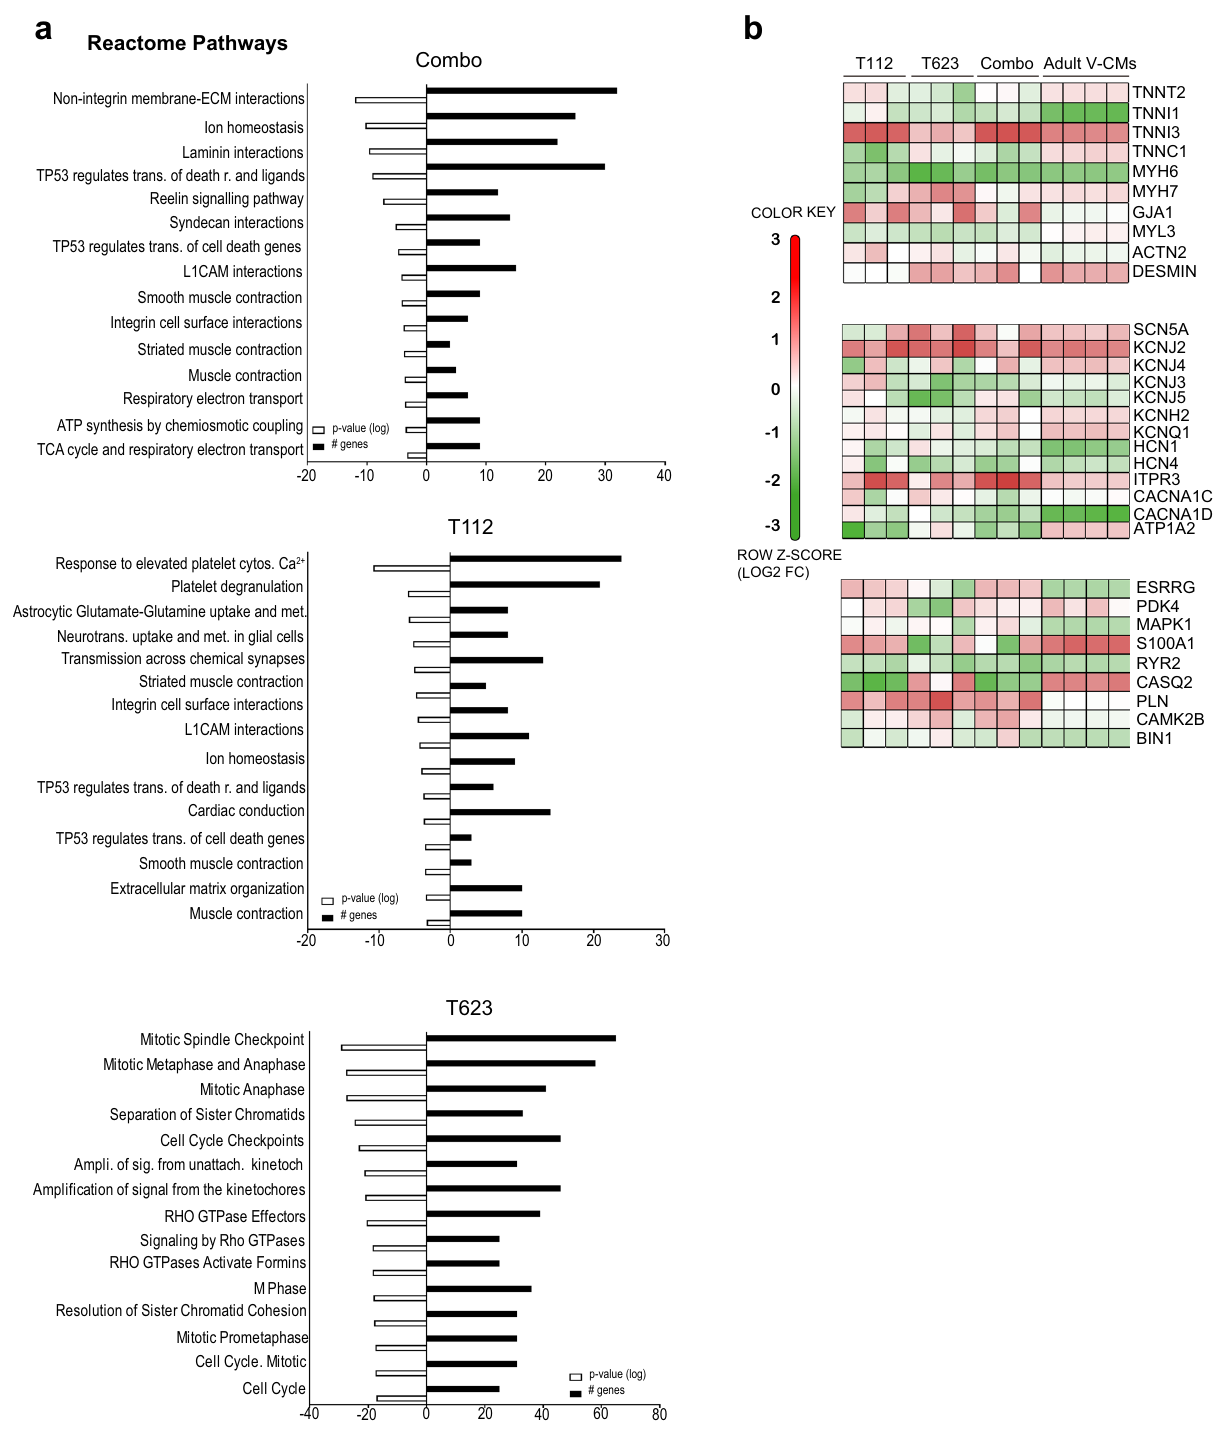
Fig. 4 Transcriptomic pathways and gene sets enrichment. a Reactome pathway analysis for T623-, T112- and Combo-treated CMs. Enriched pathways were calculated using the binomial test over DE genes between individual conditions compared to DMSO. The top 15 statistically signi fi cant pathways are listed. P -values are displayed as logarithmic form (log). b Gene set analysis of cardiac maturation-speci fi c